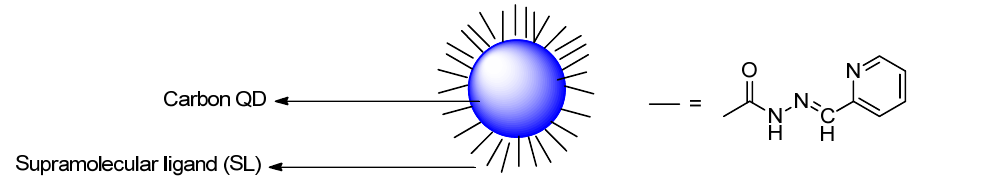
Figure 42. Structure of CQDs–SL synthesized by Devi et al.